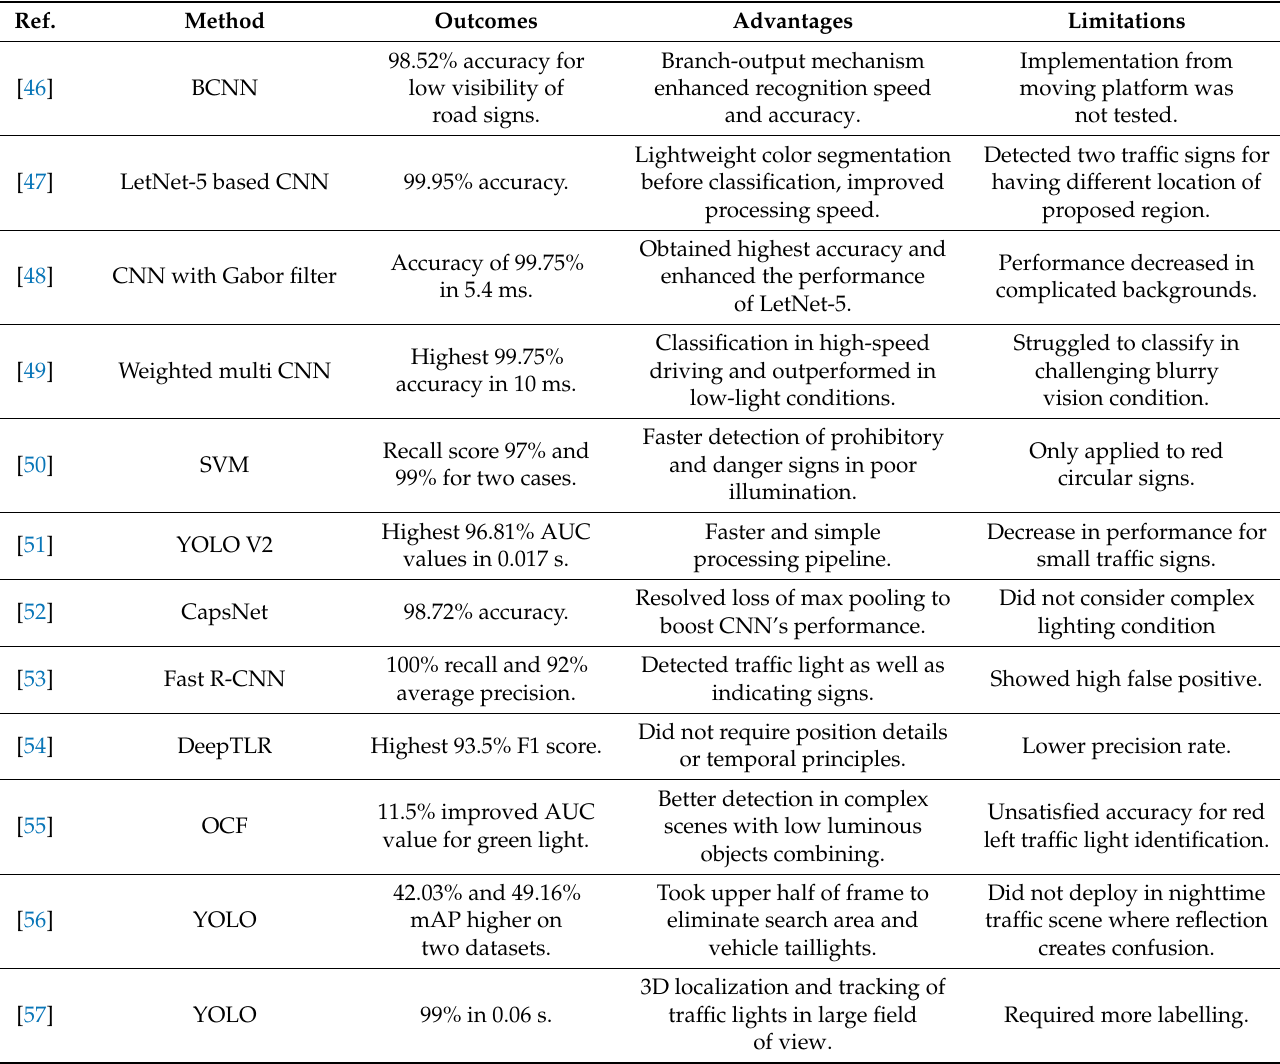
Table 6. Summary of multiple deep learning methods for traffic sign and light recognition.